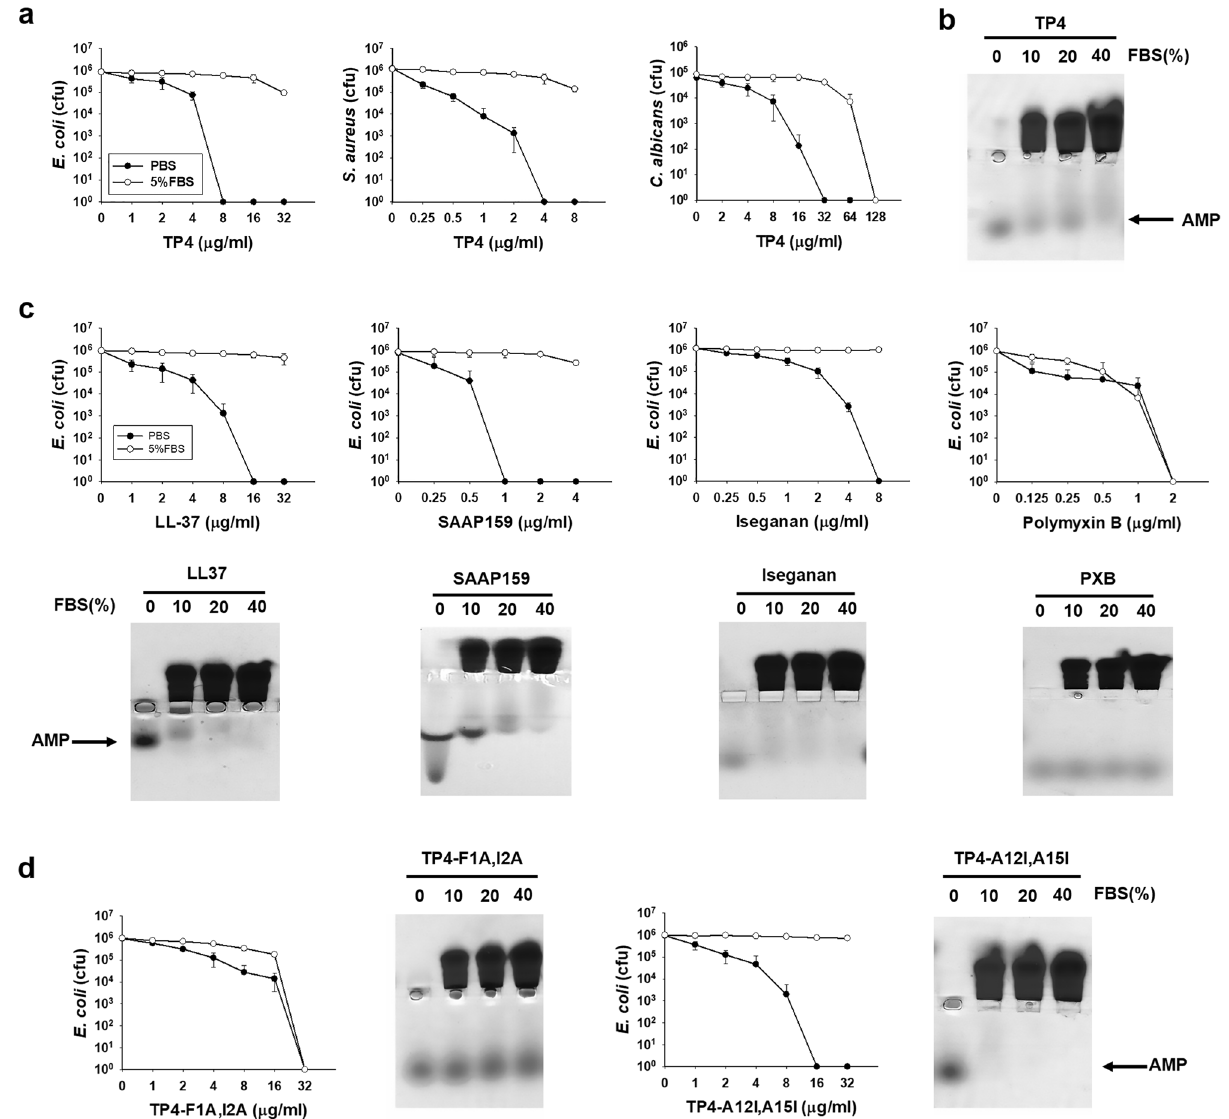
Figure 1. Susceptibility of antimicrobials to serum inhibition. ( a ) Effect of fetal bovine serum on the antimicrobial activity of TP4 to E. coli (left), Staphylococcus aureus (middle) bacteria and Candida albicans (right). ( b ) The band shift of TP4 caused by fetal bovine serum. ( c , d ) Effect of fetal bovine serum on the antimicrobial activities of cationic antimicrobial peptides and TP4 mutants to E. coli (top or left panel) and band shift of antimicrobials (4 μg each) caused by serum (bottom or right panel). PBS, phosphate-buffered saline; 5% FBS, 5% (v/v) fetal bovine serum in